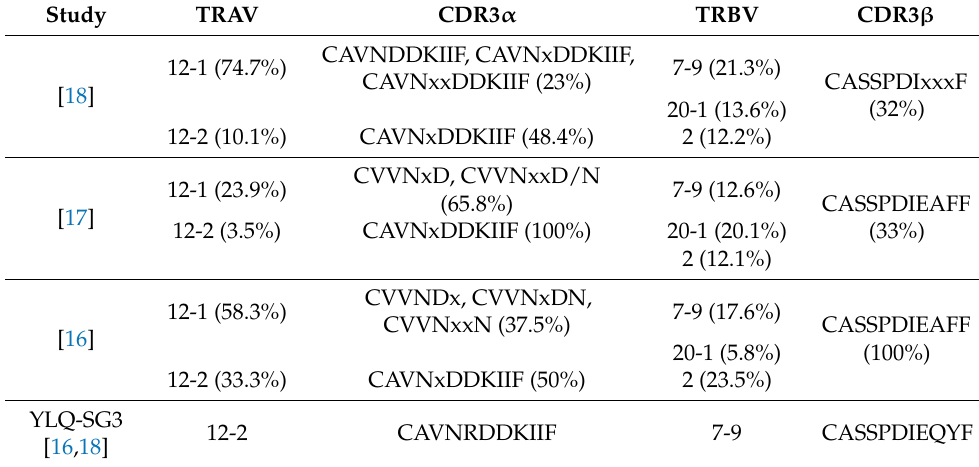
Table 4. YLQ-specific biased TCR